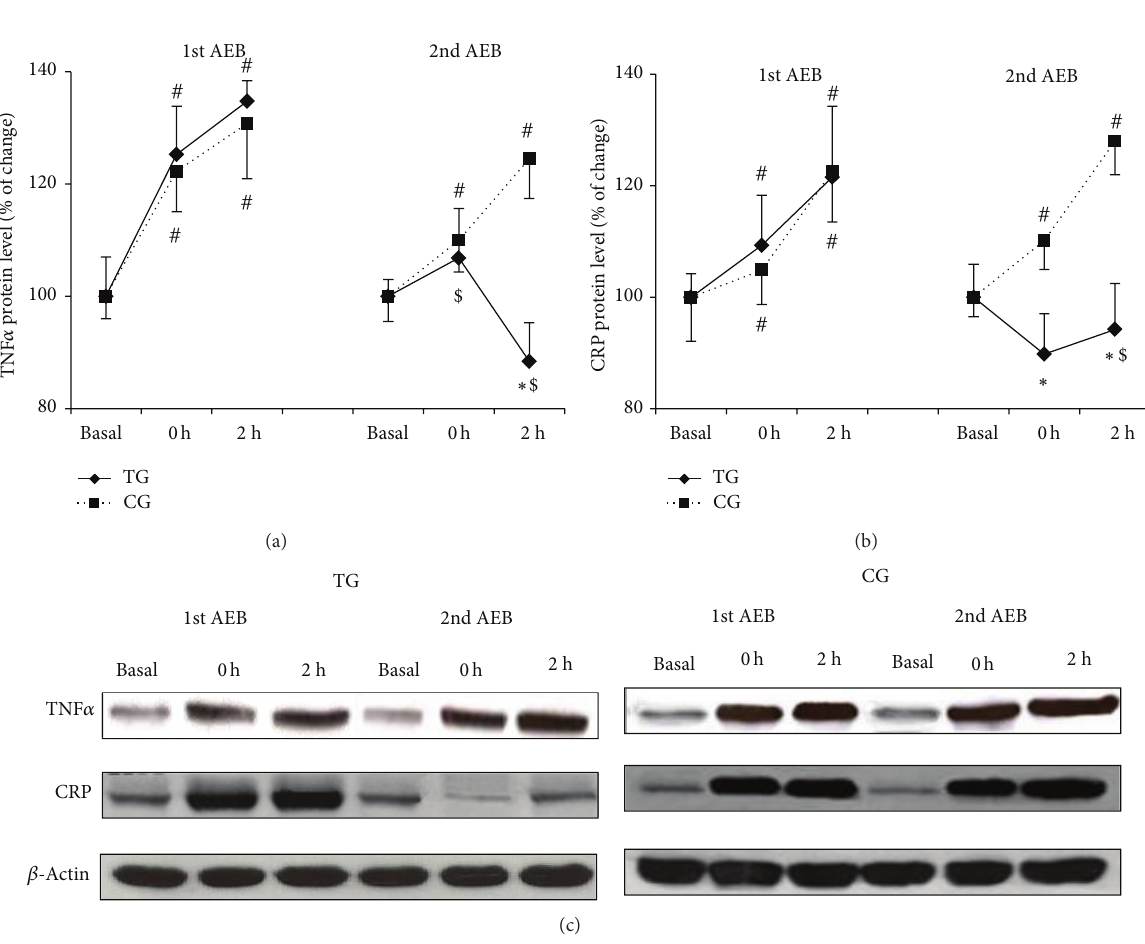
Figure 4: Training reduces TNF 𝛼 and CRP overexpression after eccentric exercise. TNF 𝛼 (a) and CRP (b) protein levels after the first and the second acute eccentric bout (AEB) for training group (TG, solid line) and control group (CG, dotted line), and representative Western blots (c). Mean ± SEM. ∗ 𝑃 < 0.05 versus CG; # 𝑃 < 0.05 versus basal value, same group; $ 𝑃 < 0.05 versus 1st acute eccentric bout, same